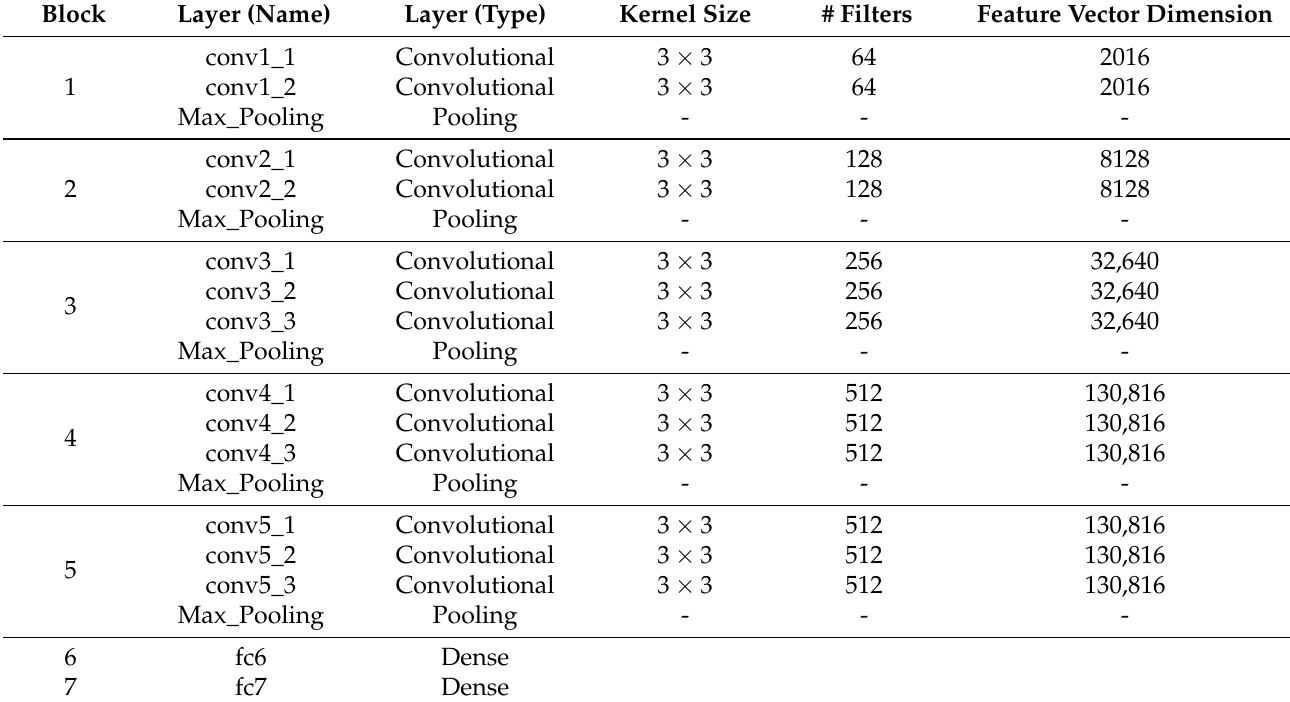
Table 1. Summary of the VGG16 [30] architecture alongside the resulting feature vector dimension with respect to the intra-layer